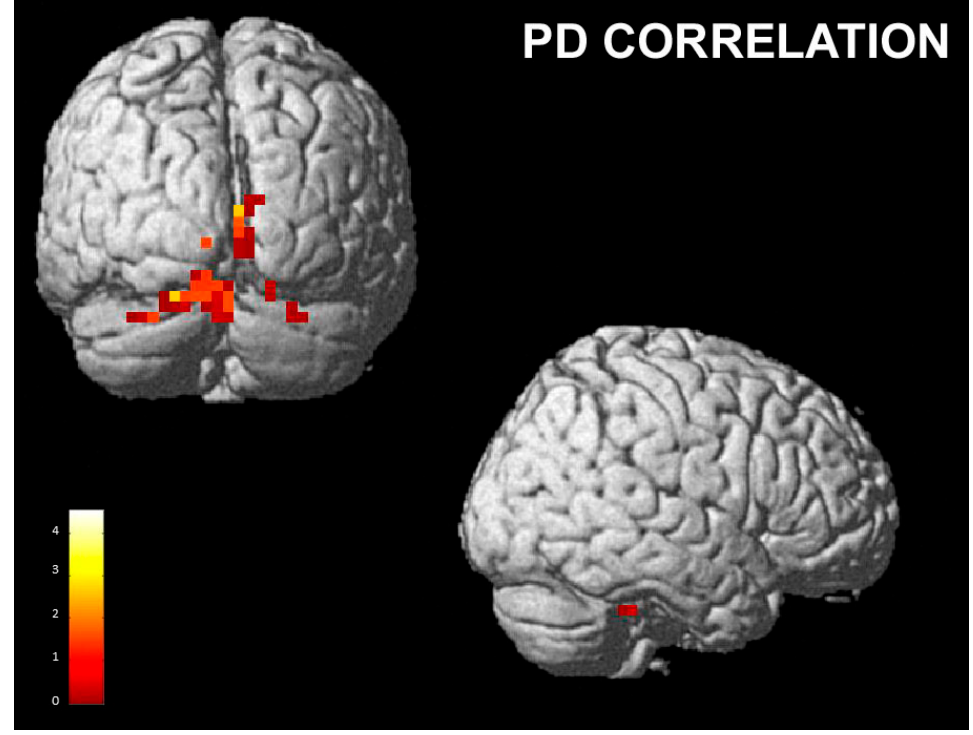
Figure 6. PD correlation with the contrast “perceived happiness” vs. “perceived disgust”; cluster size threshold k > 31, corrected at α < 0.05. Same overlay procedure as in Figure 3. In addition, we found a significant positive correlation with the right lingual gyrus and bilateral cerebellum when posing with a neutral expression and perceiving happiness compared to posing with a neutral expression and perceiving disgust (Nh vs. Nd) (Table 5; Figure 7). Table 5. Peak coordinates of positive correlation with the Personal Distress subscale. Brain Areas Nh vs.